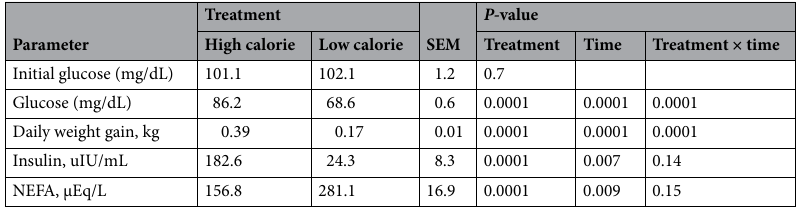
Table 2. Effect of the high calorie and low-calorie treatments on body weight, glucose and insulin. Except for initial glucose, the values represent overall mean of the experimental period.